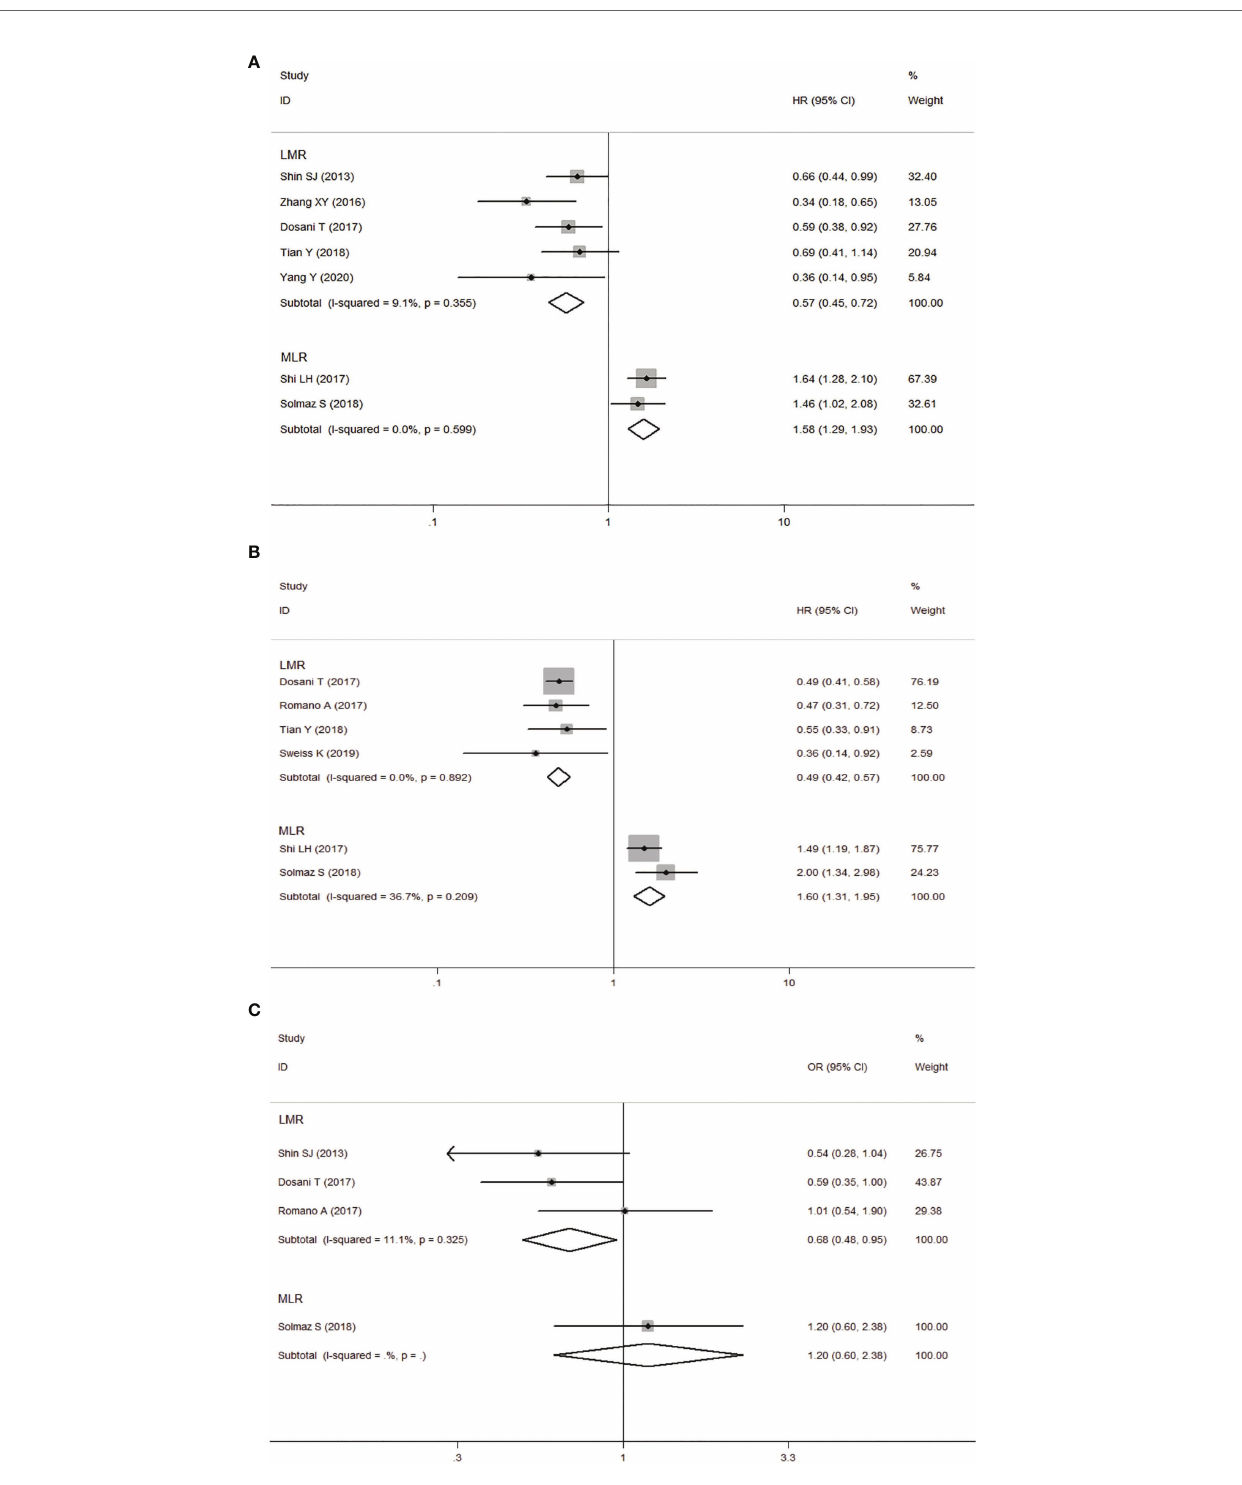
FIGURE 4 | Forest plot for the association between lymphocyte-to-monocyte ratio (LMR) or monocyte-to-lymphocyte ratio (MLR) and OS (A) /PFS (B) of patients with multiple myeloma (MM). (C) Forest plot of the association between LMR/MLR and ISS